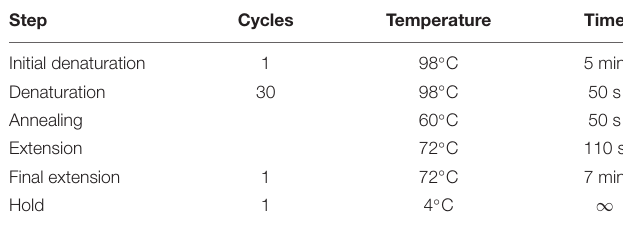
TABLE 3 | AtIRE1a-KR site-directed mutagenesis PCR cycling instructions.